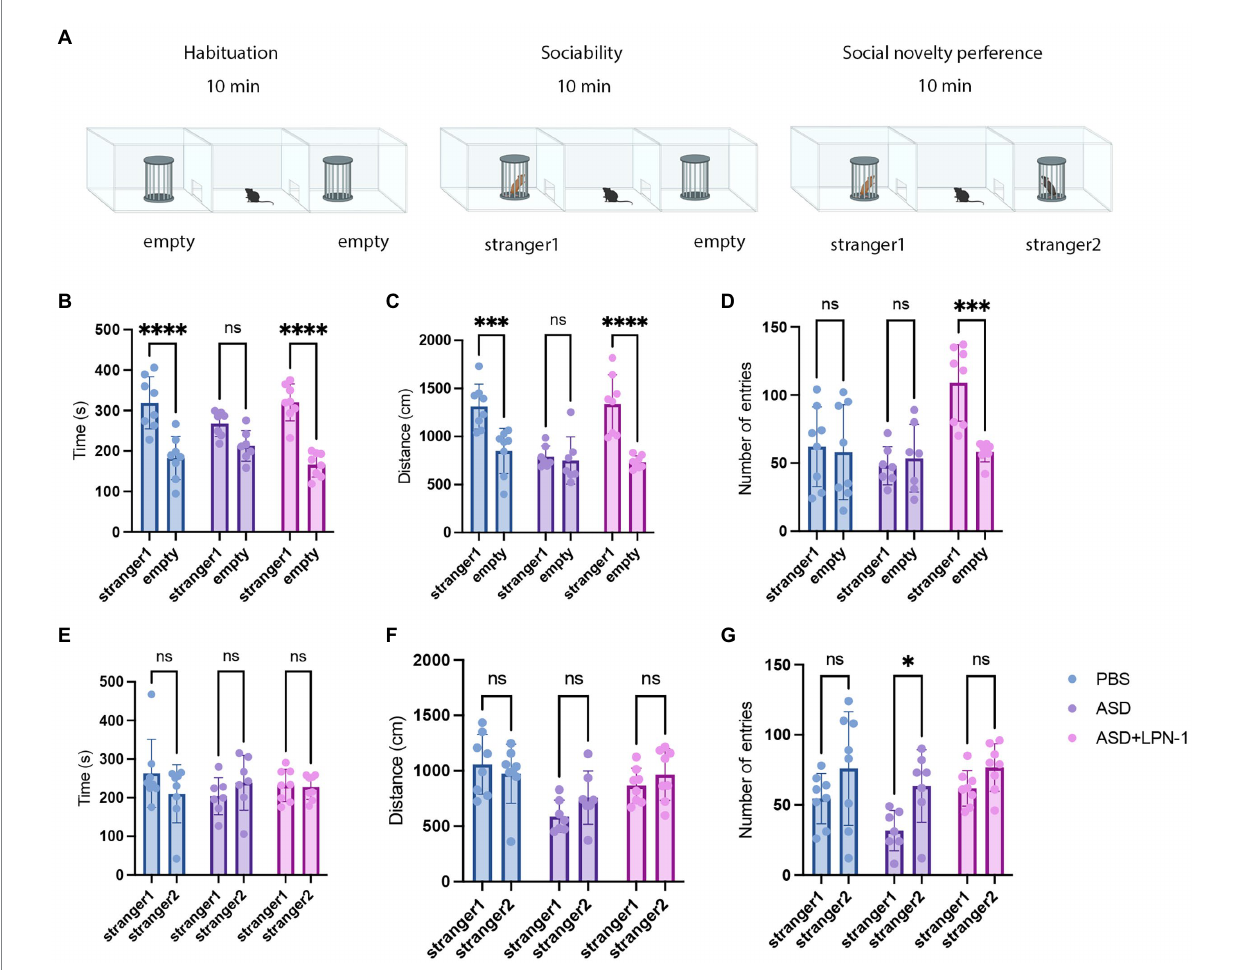
FIGURE 2 Sociability and social novelty in mice, phosphate-buffered saline (PBS) ( n = 8), ASD ( n = 7), ASD + LPN-1 ( n = 8). (A) Schematic representation of the three- chamber social interaction test. Sociability test (B–D) : Time spent near the wire cage with stranger 1 (B) , distance walked around stranger 1 (C) , and number of entries (D) . Social novelty preference test (E–G) : Time spent near the wire cage with stranger 2 (E) , distance walked around stranger 2 (F) , and number of entries (G) . * p < 0.05, ** p < 0.01, *** p < 0.001, **** p <